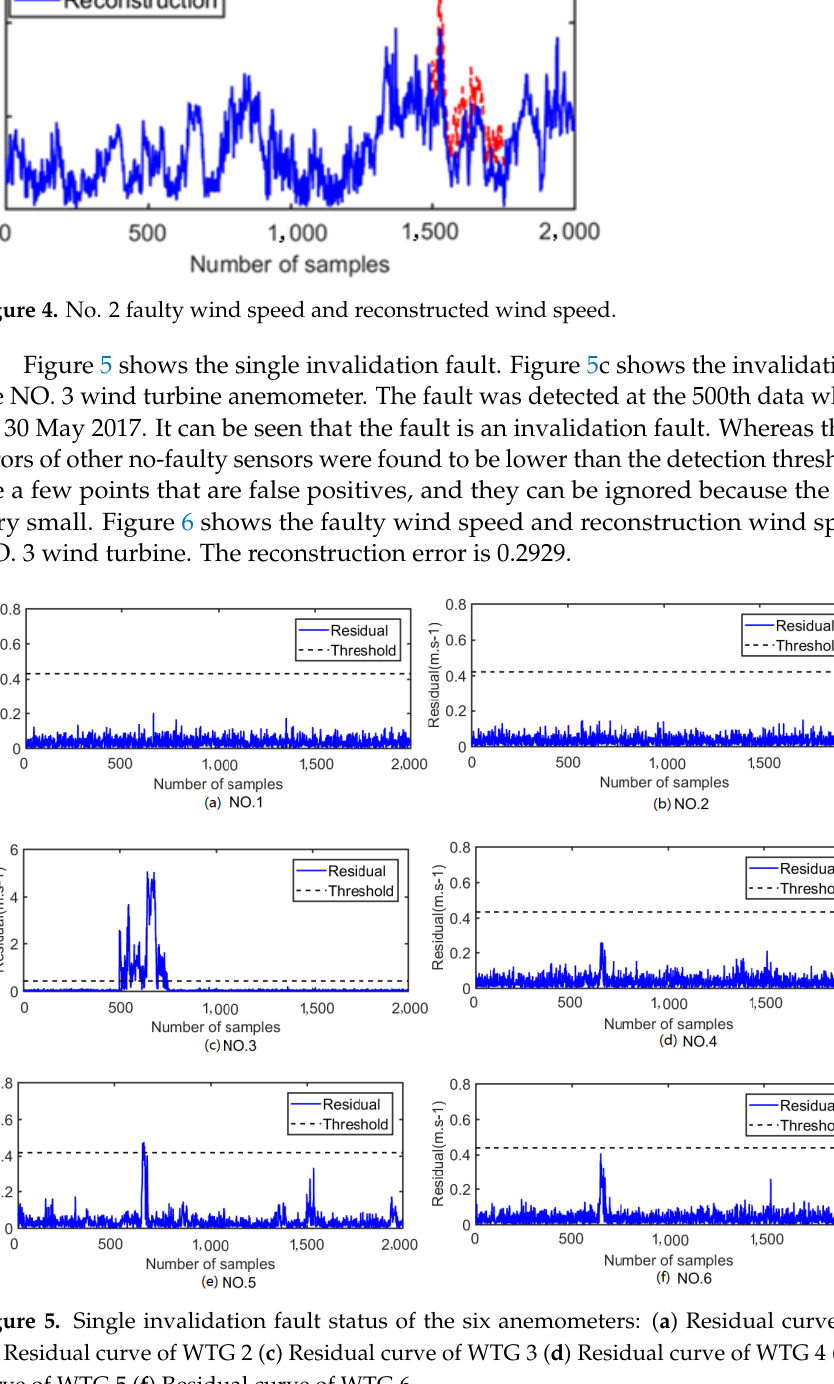
Figure 3. Single fixed deviation fault status of the six anemometers:( a ) Residual curve of WTG 1; ( b ) Residual curve of WTG 2 ( c ) Residual curve of WTG 3 ( d ) Residual curve of WTG 4 ( e ) Residual curve of WTG 5 ( f ) Residual curve of WTG 6.